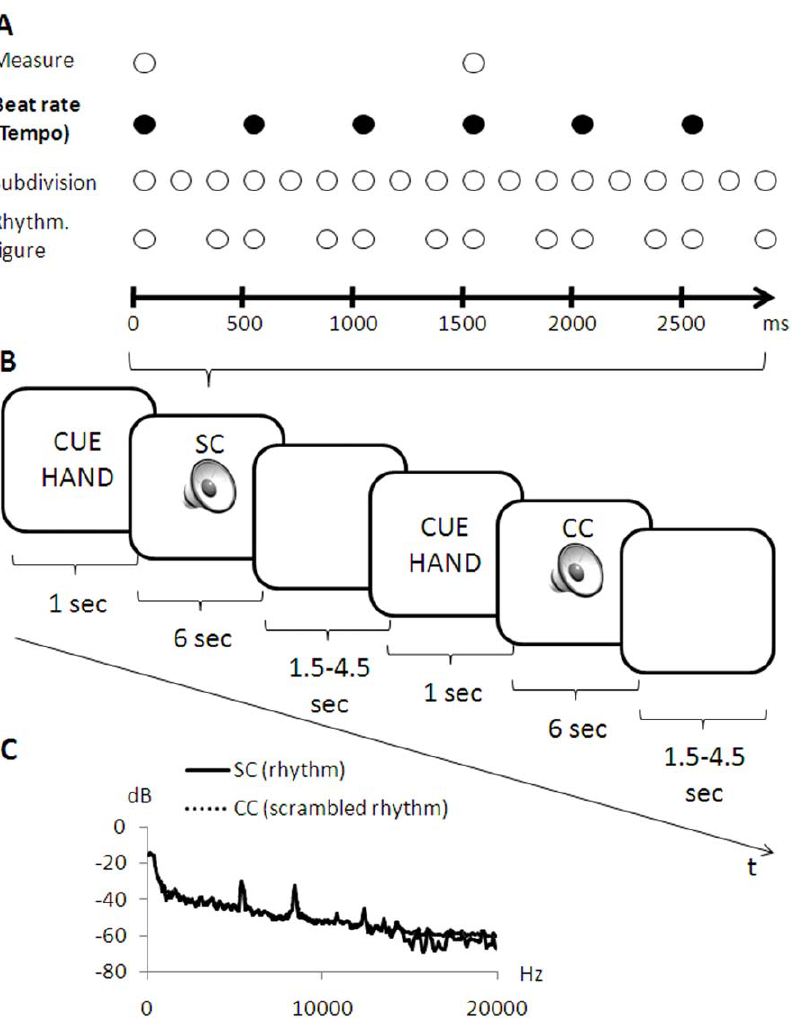
Figure 1. Stimulus material and trial structure. A : The auditory stimulus was determined by the factors beat rate (tempo/inter-onset-interval of beats; 1.7, 2.0 or 2.5 Hz), measure (the grouping of beats), beat subdivision (elements per beat), rhythmic figure and a factor unrelated to sub-second timing, timbre (spectro-temporal configuration of the sound stimulus), that varied on two or three levels respectively (cf. stimulus examples: Sounds S1, S2, S3, S4, S5, S6). Beat rate (filled circles) served as a cue for auditory-motor synchronization. The depicted rhythm example possesses a middle tempo with three beats per measure, three elements per beat and a repetitive rhythmic figure containing a long, followed by a short interval. B : Each trial started with an auditory cue (sinusoidal tone of either 400 or 1200 Hz, assignment counterbalanced across subjects), indicating whether to tap with the right or the left index finger, followed by the stimulus and a pause, which varied depending on the jitter times. In the synchronization condition (SC) subjects were instructed to tap to the respective periodic beat of the musical rhythm with the right or the left index finger according to the preceding cue. In CC subjects were presented with scrambled versions of musical rhythms (randomized 10 ms segments of the respective rhythms). The subjects’ task was to tap regularly in a self-paced manner. C : The spectrum of the scrambled rhythms in CC closely matched that of the rhythms in the SC (cf. trial examples: Sound S7).